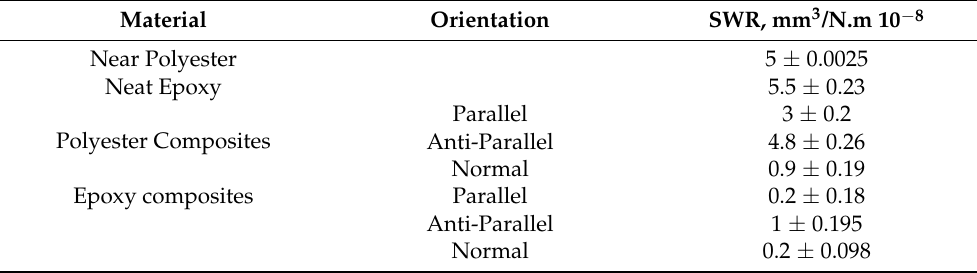
Table 1. Summary of the specific wear rate (SWR) of polyester and epoxy composites considering different orientations at applied load of 30 N after 10 km sliding